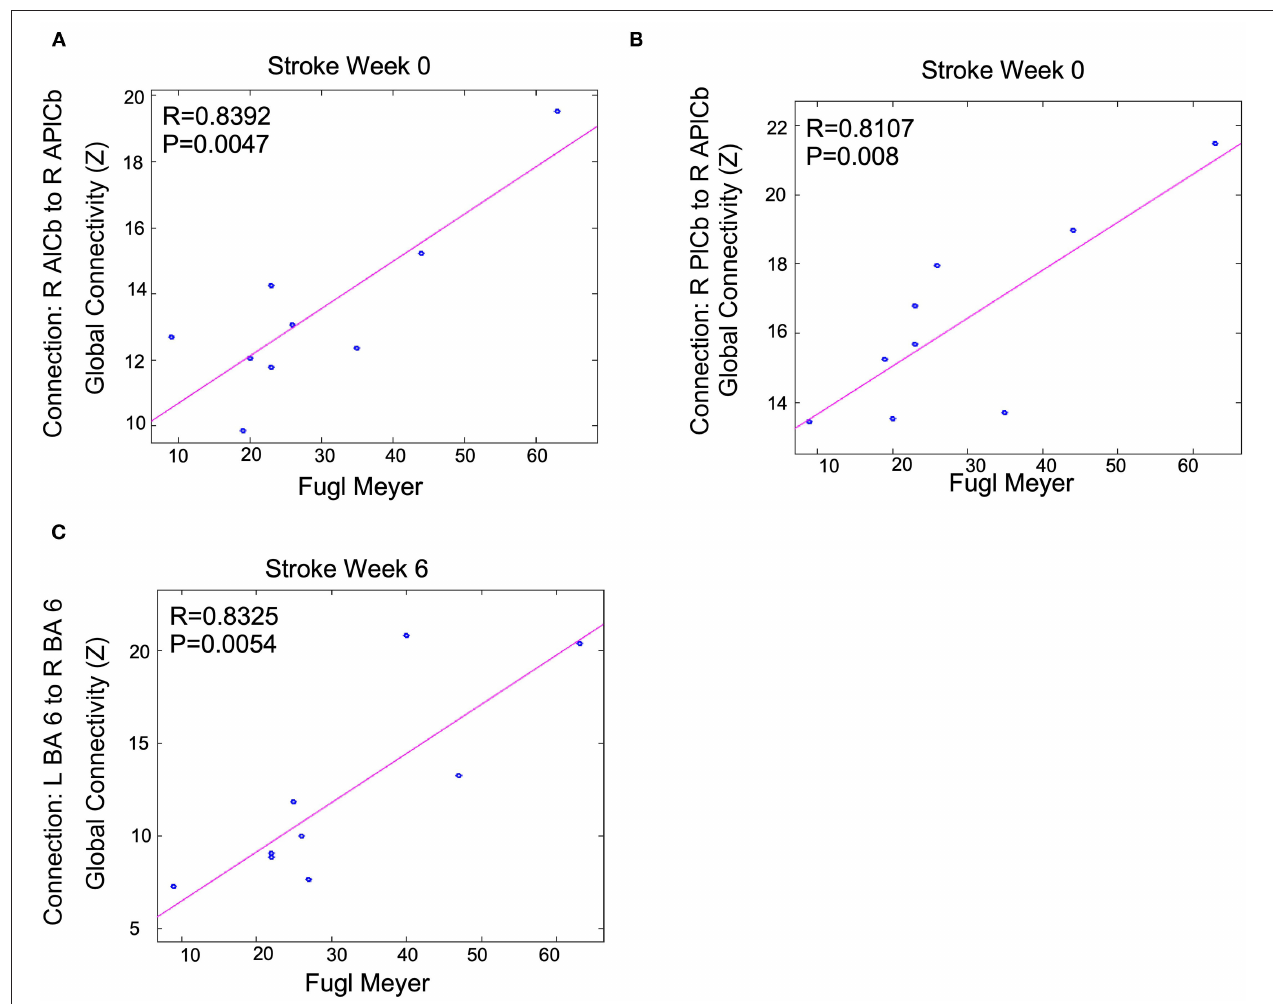
FIGURE 8 | Functional connectivity measurements correlated with FMA scores following BoNT-A injection therapy: trends are shown above. Shown P -values are without correction for multiple comparisons across all tests run for all connections and clinical measurements. We only show the largest trends with these uncorrected p < 0.01. R is the correlation coefficient. R, right; L, left; BA, Brodmann’s Area; A, Anterior; P, Posterior; lCb, lobule of the cerebellum. This shows Fugl Meyer scores correlation to (A) the connection between R AlCb to R APlCb, (B) the connection between R PlCb and R APlCb, and (C) the connection between L BA 6 and R BA